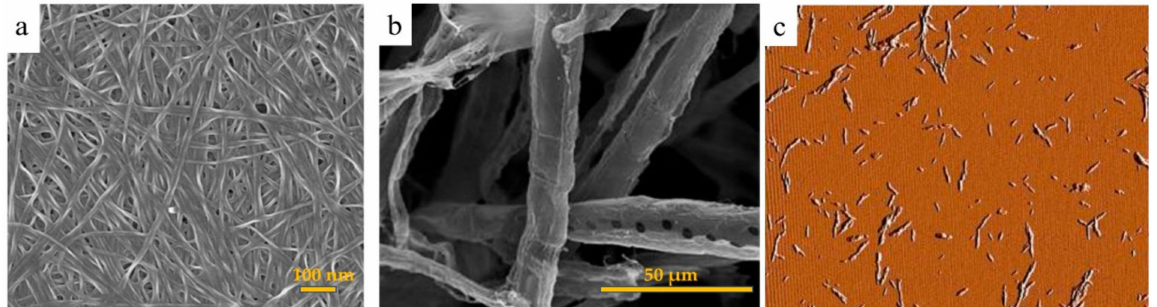
Figure 4. Scanning electron micrographs of ( a ) BNC [59], ( b ) Kraft bamboo pulp MFC [60], and ( c ) Atomic force microscopy (AFM) amplitude image of CNC (scan size: 5 µ m or 5 by 5 microns)